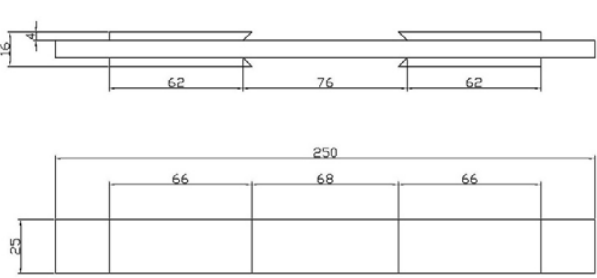
Figure 5: Shape and dimensions in mm of the samples used in the static